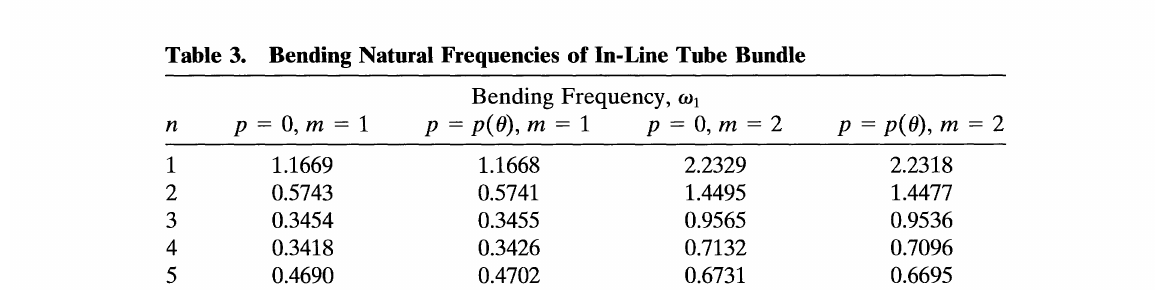
Table 3. Bending Natural Frequencies ofIn-Line Tube Bundle Bending Frequency,